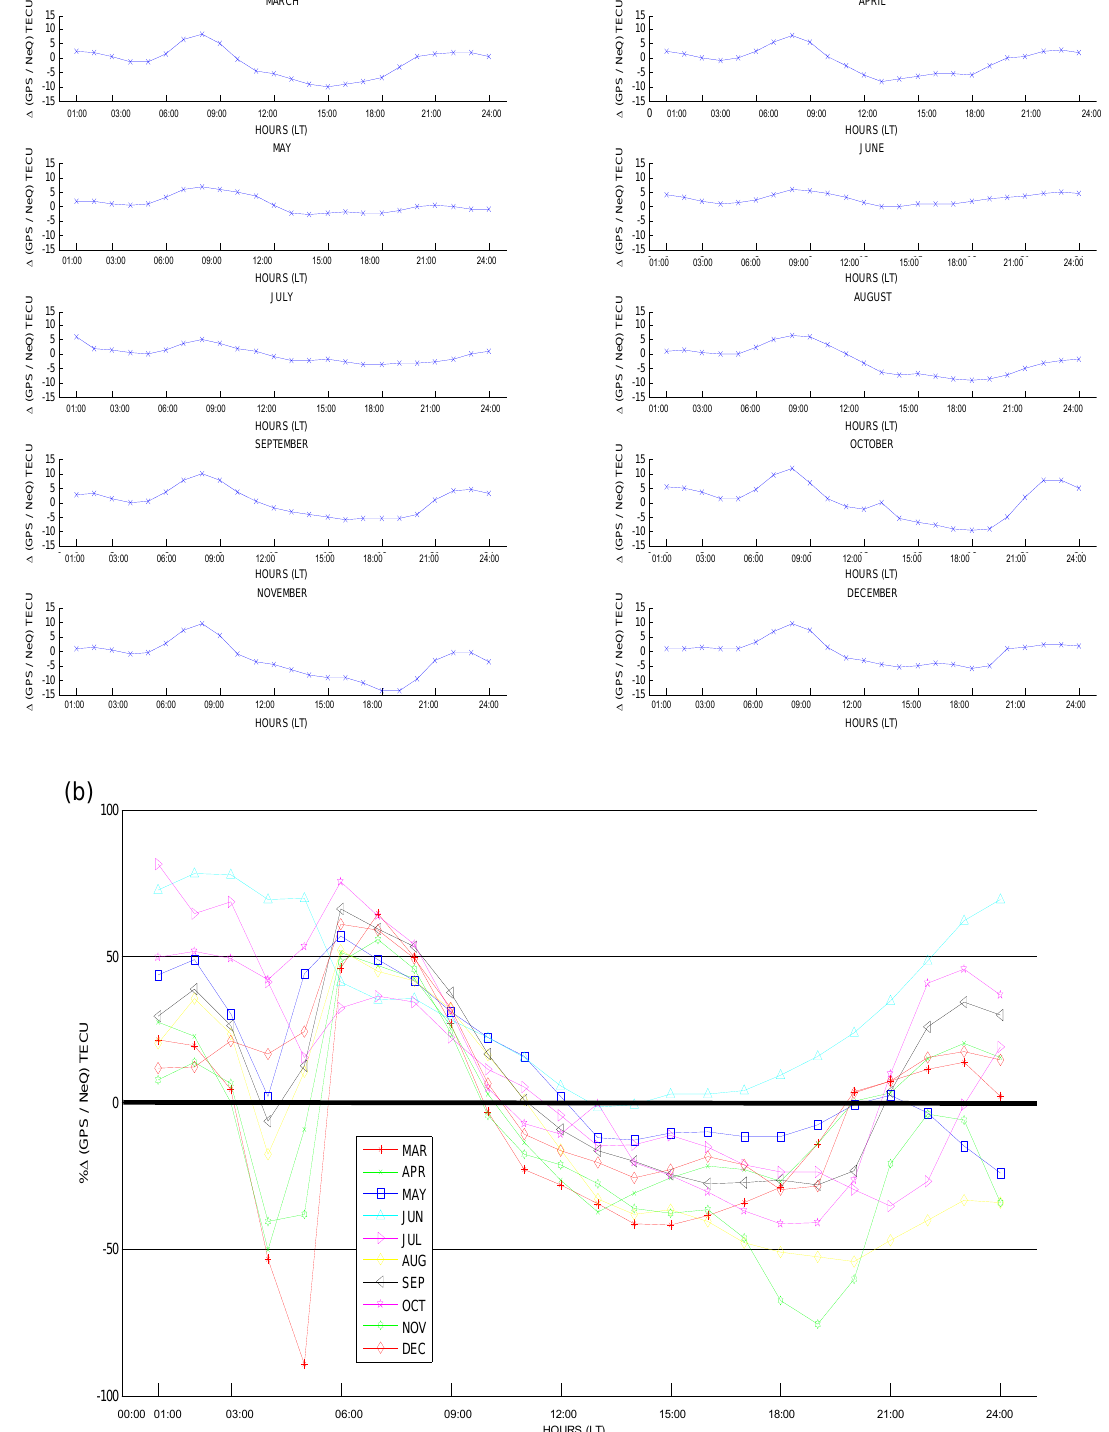
Figure 4. (a) Hourly variations in (cid:49) TEC between the GPS TEC and NeQ TEC from March to December during a quiet period. (b) Mass plot of % (cid:49) TEC between the GPS TEC and NeQ TEC from March to December during a quiet period. The line colors and symbols are the same as in Fig.